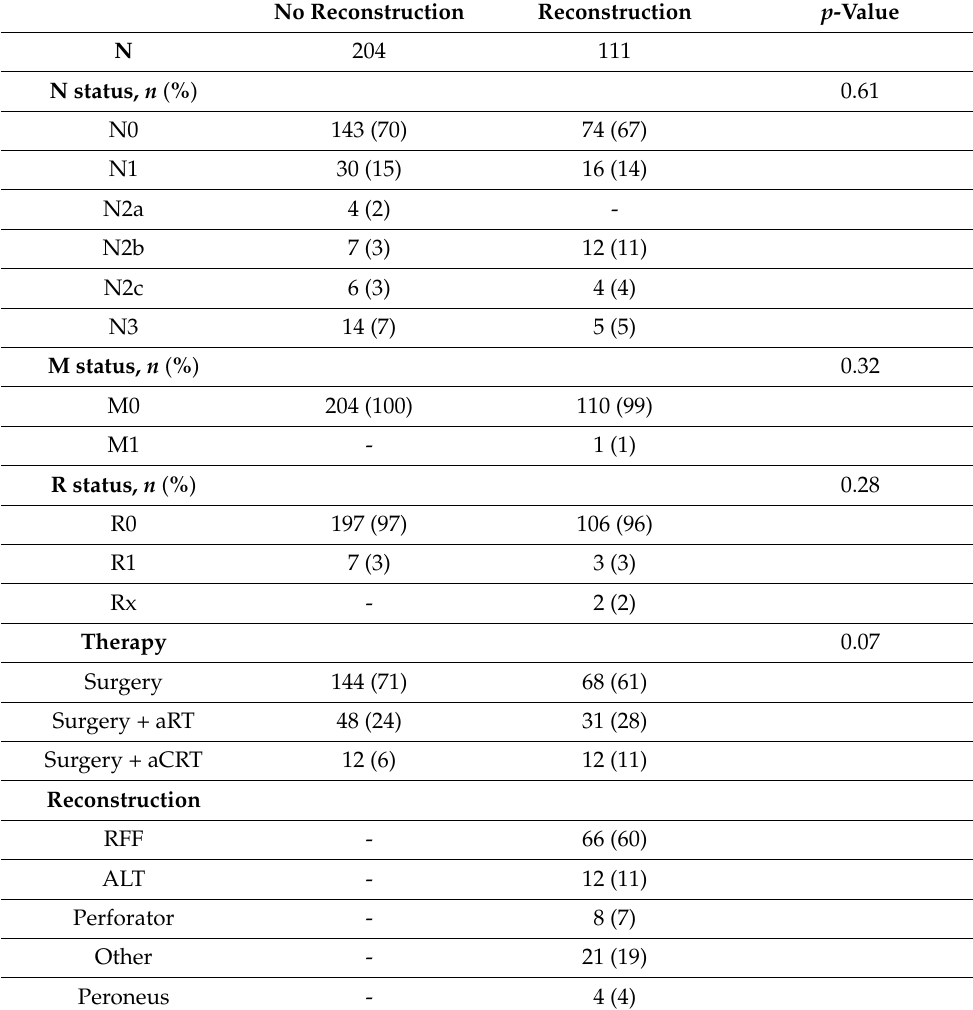
Table 4. Calculation of N, M, R stages, therapy, and reconstruction method for T1/2 cases only. No Reconstruction Reconstruction p